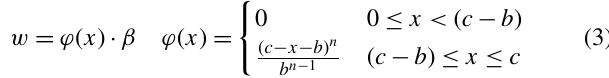
dius are determined similarly by dividing the blade into dif- ferent radial